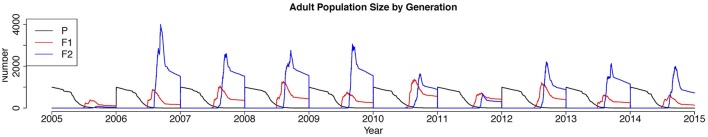
Model predictions of adult population size for Wenatchee, WA. P represented parental overwintered adults, which was initialized as 1,000 for each year and for each simulation run.